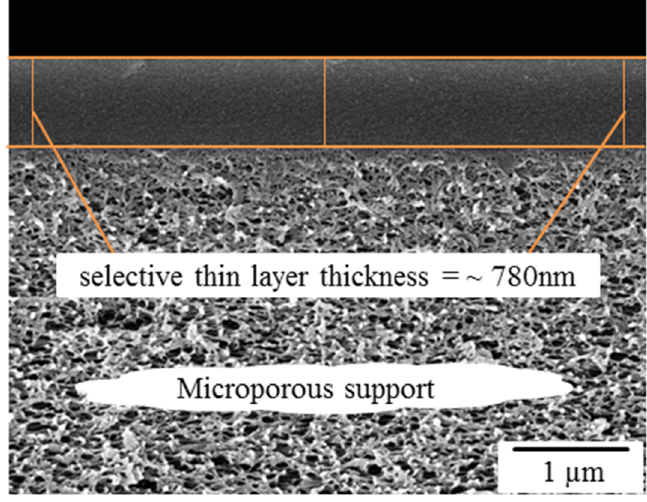
Figure 4. Cross section SEM image of PIM-1 polymer thin-film composite membrane.